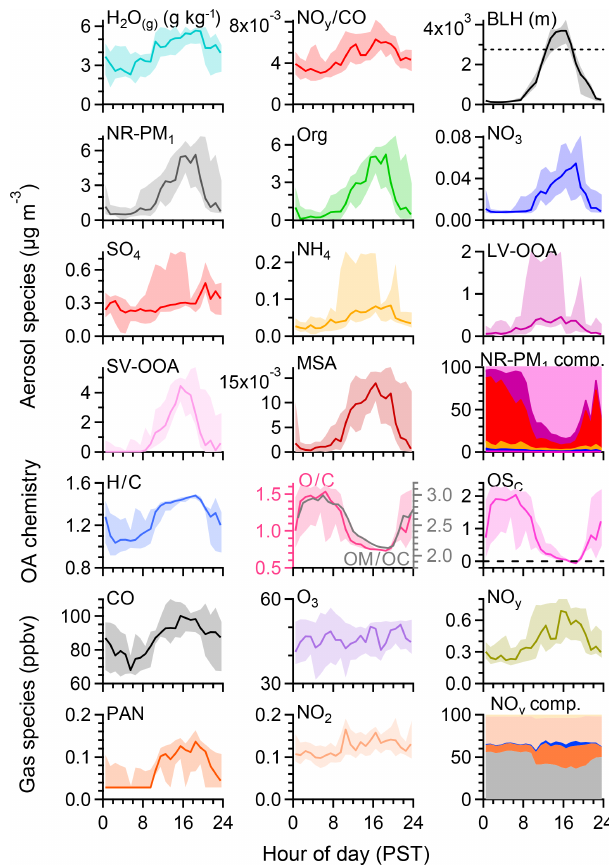
Figure 2. Diurnal cycles of the median values of water vapor (H 2 O ( g ) ), NO y / CO ratio (ppbppb − 1 ), estimated boundary layer height (BLH), mass concentrations of NR-PM 1 species, elemen- tal ratios of OA, and mixing ratios of gas species at MBO dur- ing two clean periods in summer 2013. Oxidation state of carbon (OS C ) = O / C − H / C. The shaded areas indicate the 75th and 25th percentiles. The diurnal cycle of NR-PM 1 composition displays the percent mass contributions, from top to bottom, of SV-OOA in light pink, LV-OOA in dark purple, sulfate in red, ammonium in orange, nitrate in blue, and chloride in purple. The diurnal cycle of NO y composition displays the percent mixing ratio contributions, from top to bottom, of NO in yellow, NO 2 in light orange, nitrate in blue, PAN in dark orange, and NO z ( = NO y − NO − NO 2 − nitrate − PAN) in grey. Dashed line in the BLH plot indicates the altitude of MBO